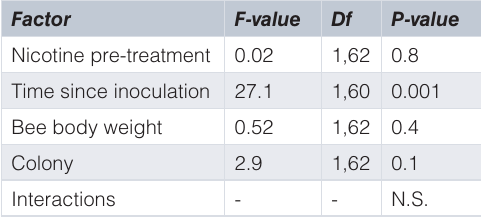
Table 2. Delayed Exposure test: results from the GLMM analysis of C. bombi population dynamics in bumblebees.